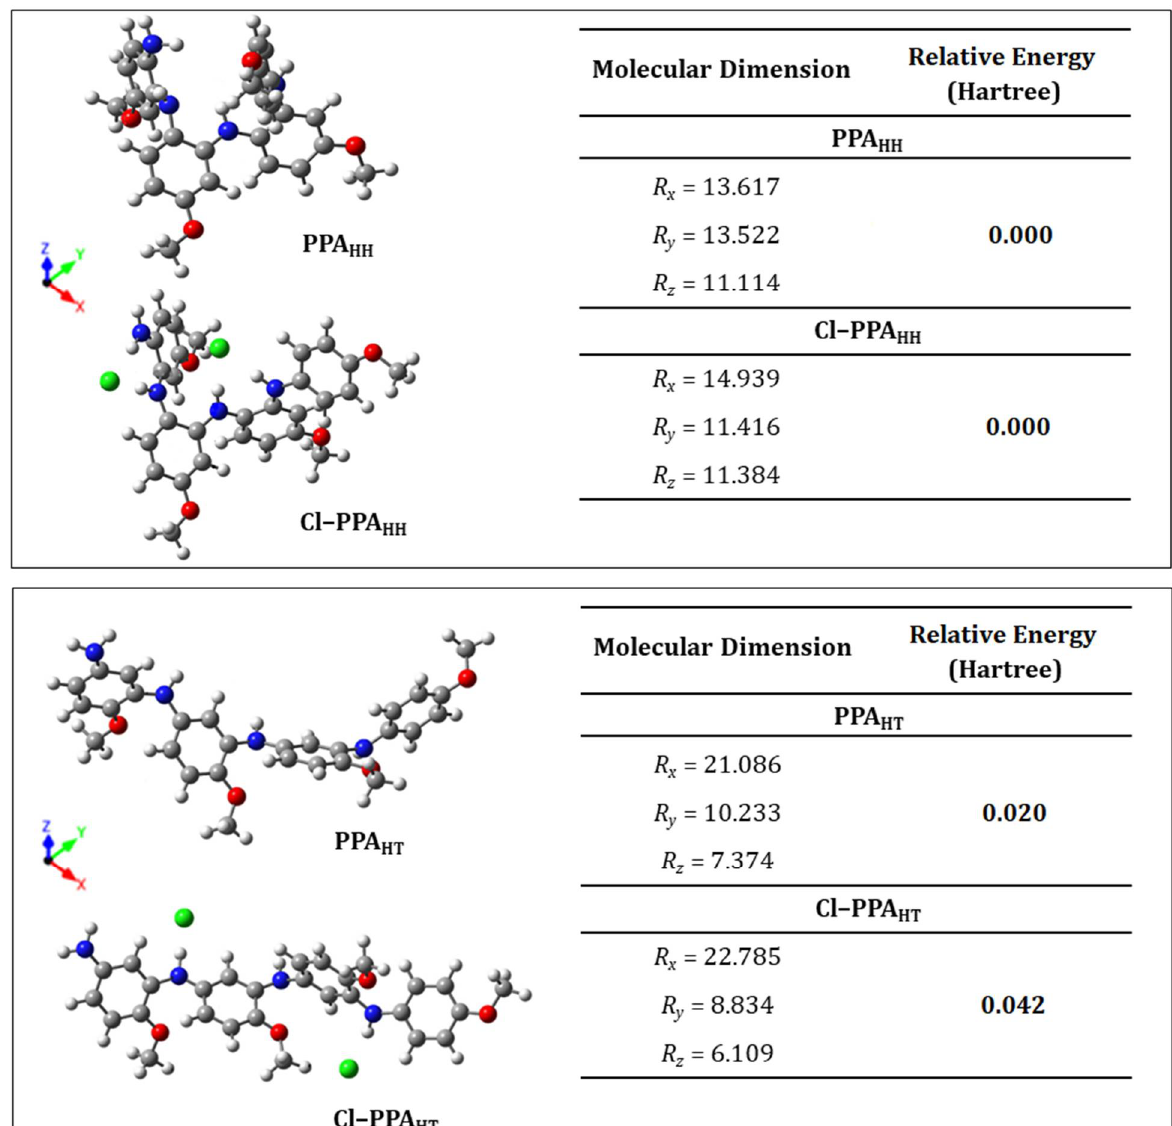
Figure 8. PPA HT , Cl–PPA HT , PPA HH , and Cl–PPA HH tetramers and their respective molecular dimensions and energy values after relaxation.